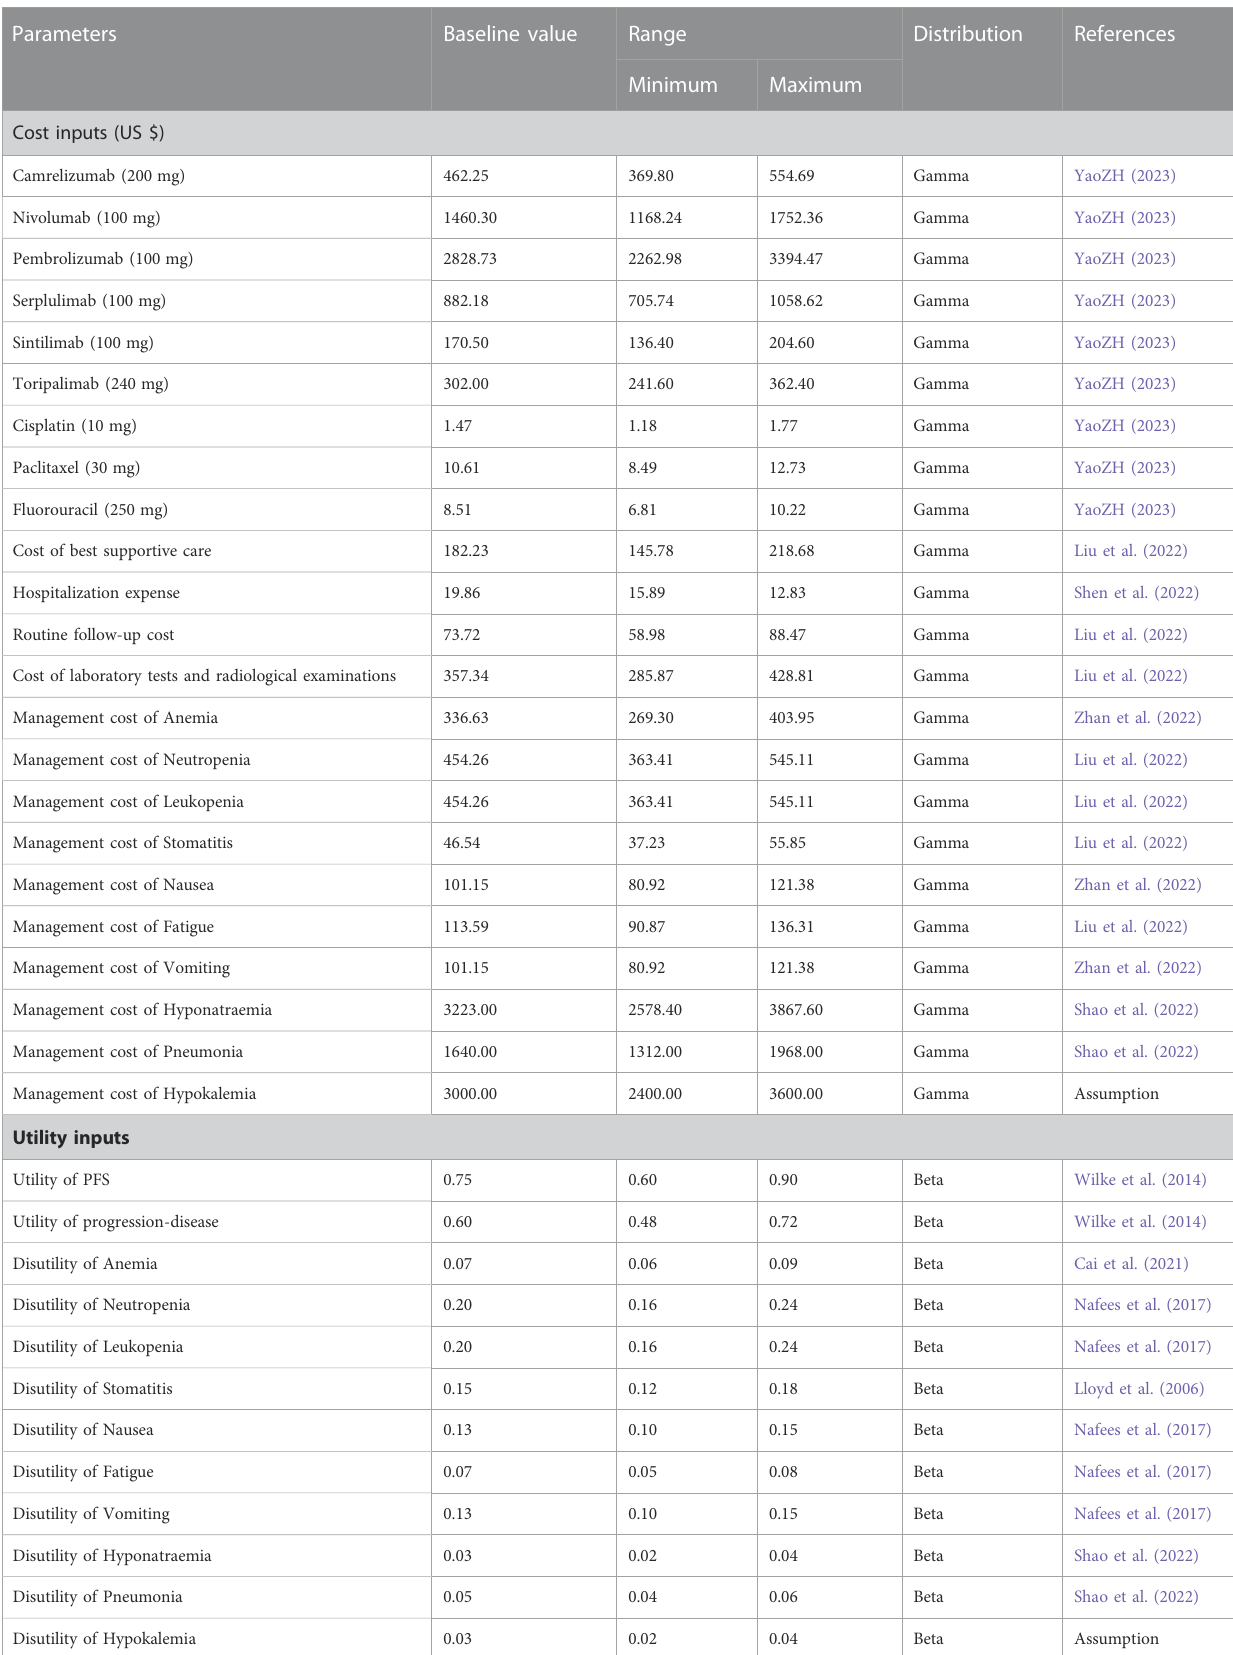
TABLE 2 Basic parameters input to the model and the ranges of the sensitivity